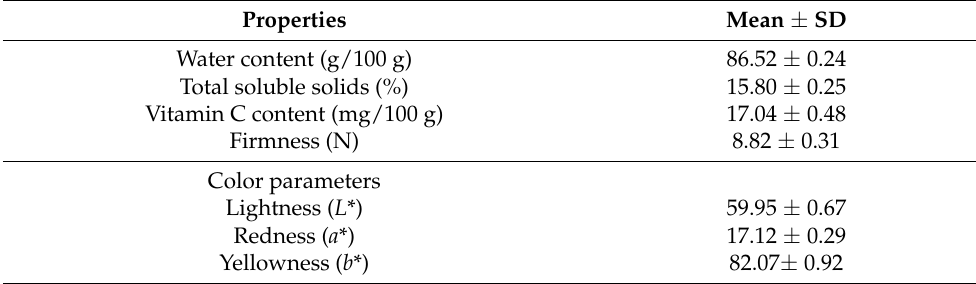
Table 1. Physicochemical properties of fresh mangoes.